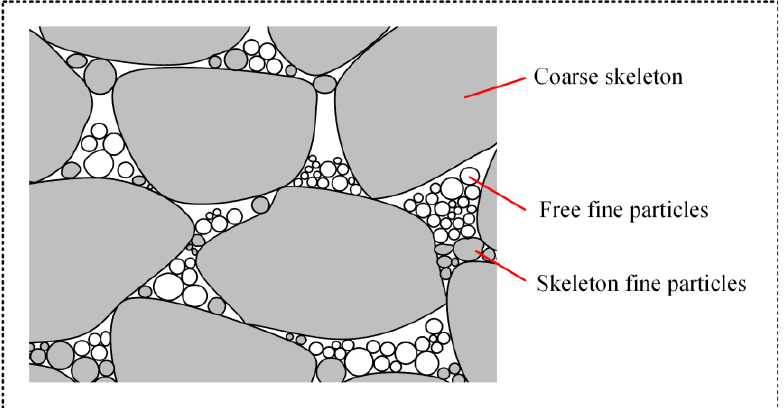
Figure 8. Illustration of coarse skeleton, free fine particles, and skeleton fine particles.